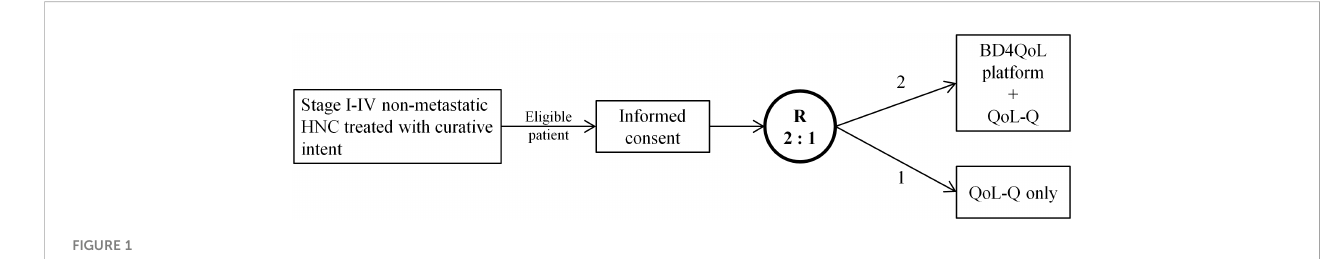
FIGURE 1 Study design of the randomized controlled